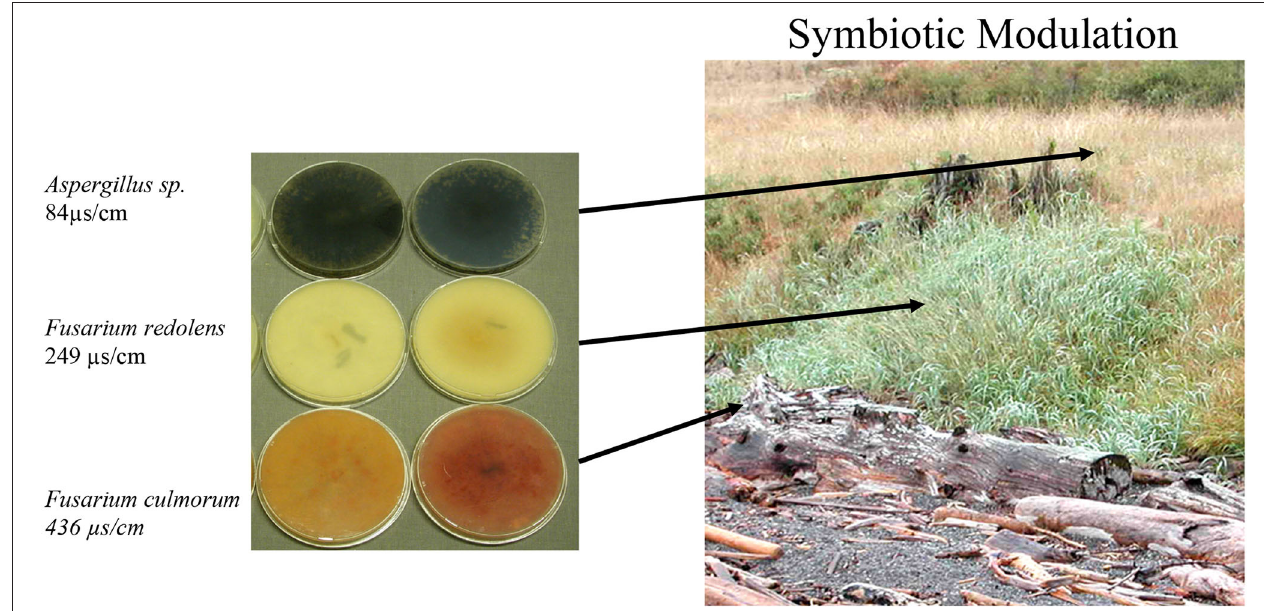
FIGURE 1 | Endophyte distribution across a salt gradient. Endophytes were isolated from plants ( N = 30/location) collected from beach, slope, and upper meadow habitats within a contiguous population of Leymus mollis (dunegrass). Fungal growth media plates (0.1x PDA) on the left represent the dominant endophyte ( < 70%) identified from plants in each location. Soil conductivity measurements were taken and the highest salinity levels found to occur on the beach, moderate levels on the slope, and low salinity levels in the upper meadow.